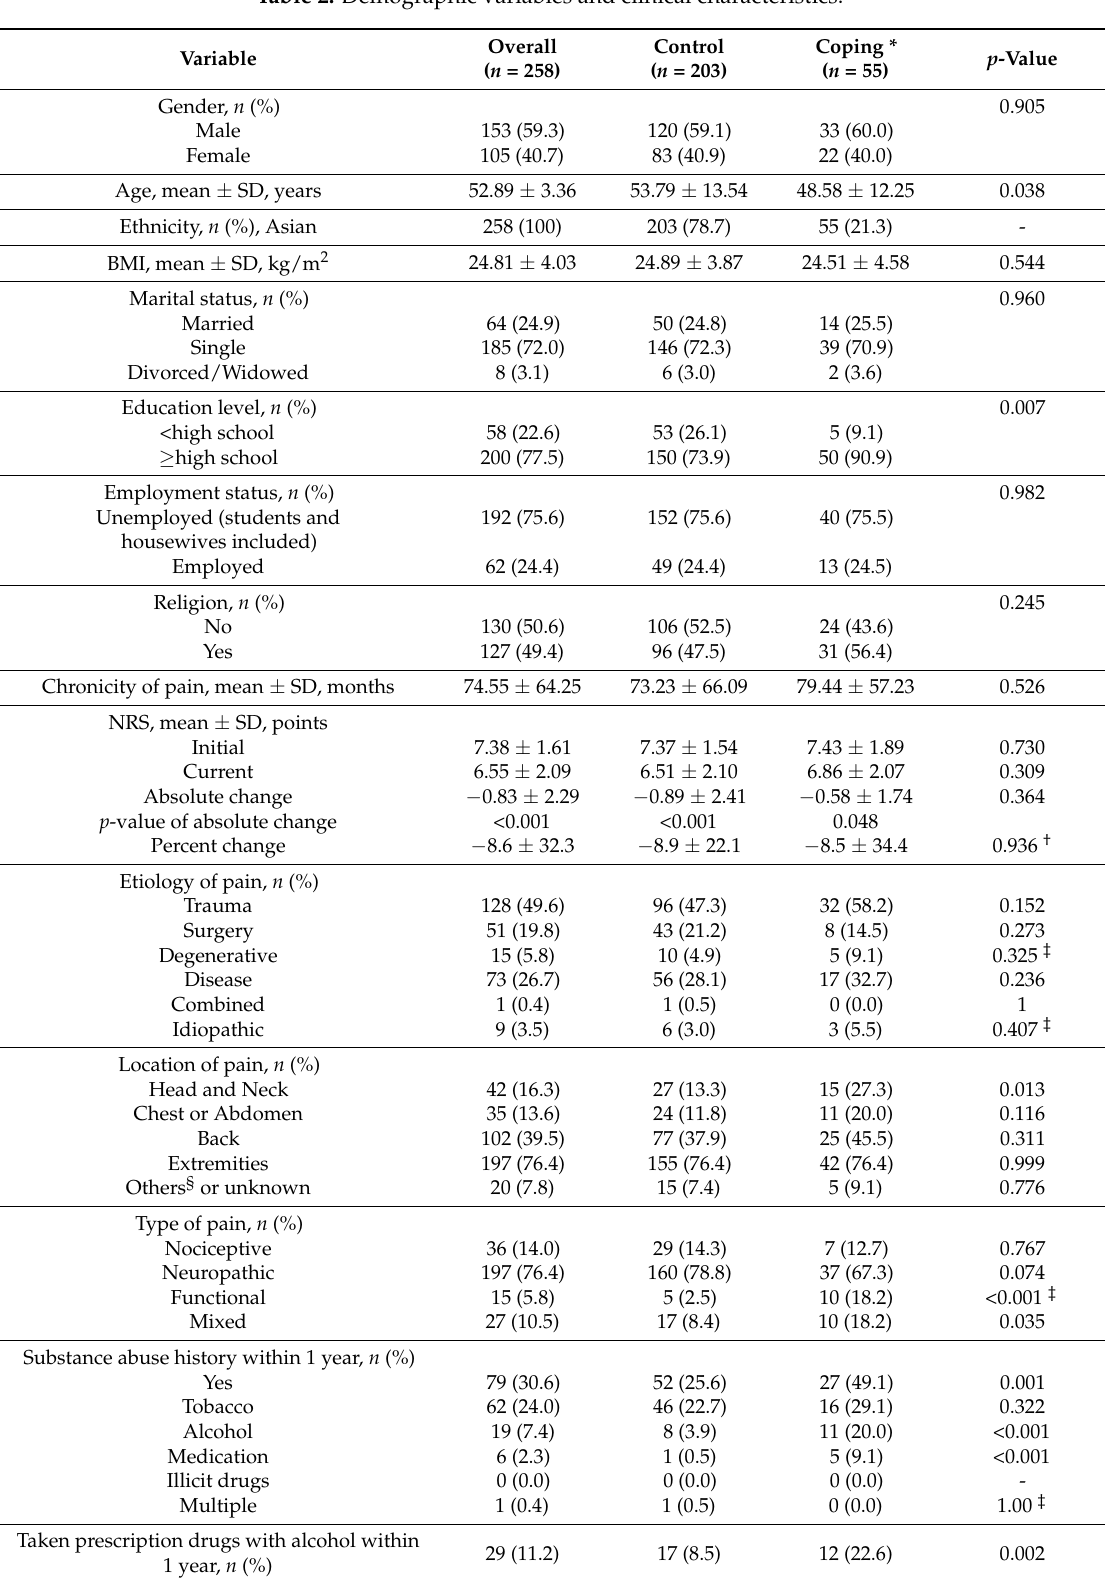
Table 2. Demographic variables and clinical